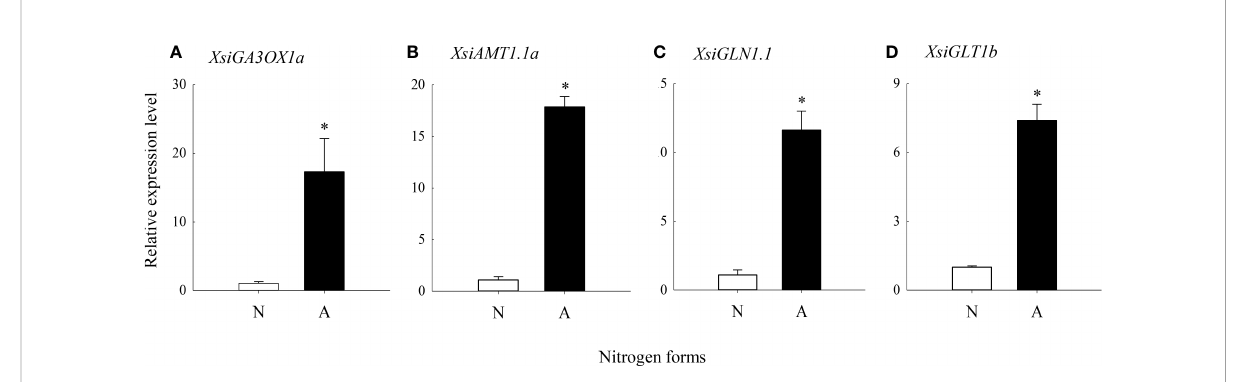
FIGURE 5 Differences in expression levels of XsiGA3OX1a (A) , XsiAMT1.1a (B) , XsiGLN1.1 (C) and XsiGLT1b (D) between nitrate (N; open bars) and ammonium ( A ; closed bars) treatments based on our quantitative real-time PCR. XsiActin1 was used as internal controls. Means + SD ( n = 3). Asterisk indicates signi fi cant difference between ammonium and nitrate treatments ( P < 0.05; independent sample t -test). The names of the transcripts were based on our phylogenetic analyses (Figures S2-5).